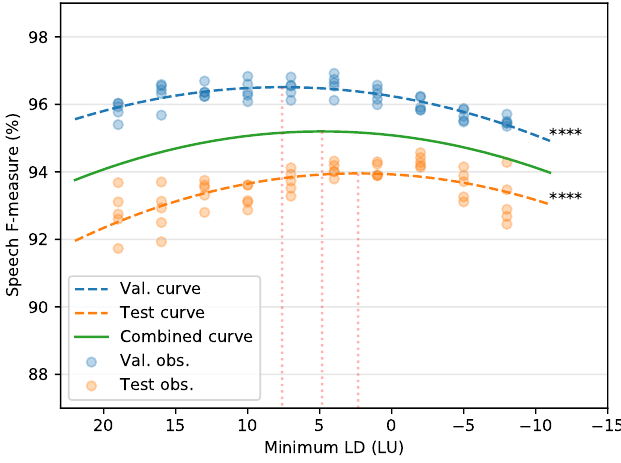
Figure 6. F-measure for different values of minimum LD. The maximum LD was fixed at 21 LU. Validation observations (Val. obs.) and test obs. are the actual values obtained in experiments. The val. and test curves were generated through quadratic curve fitting. The combined curve aggregates the observations on val. and test set for quadratic curve fitting. The vertical dotted lines in red indicate the maxima of the curves. ANOVA was performed on the observations and the asterisks indicate the level of significance (*: p < 0.05, **: p < 0.01, ***: p < 0.001, ****: p < 0.0001).